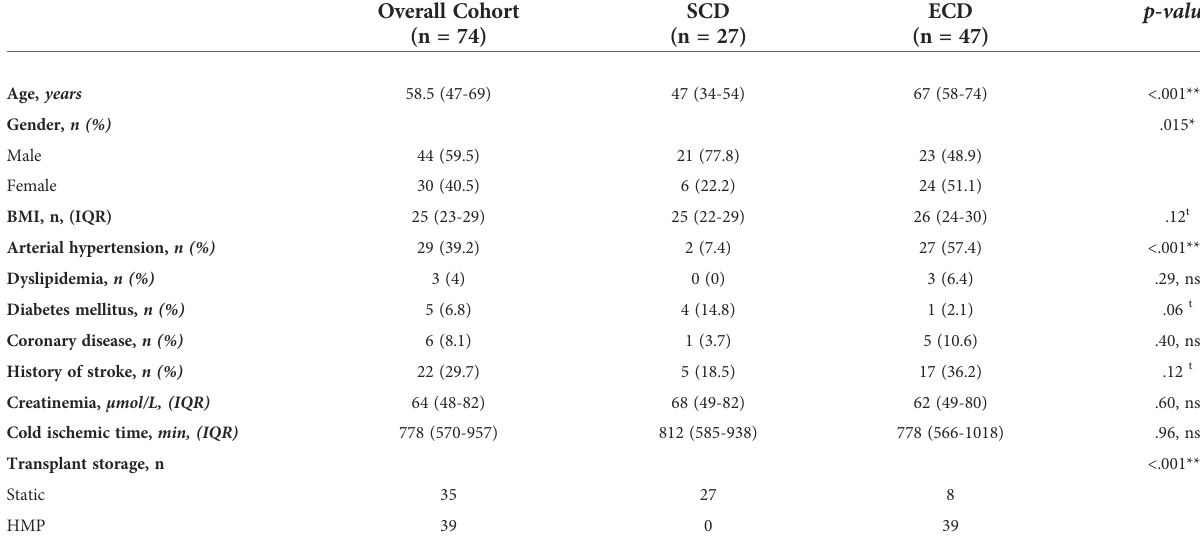
TABLE 1 Donor baseline